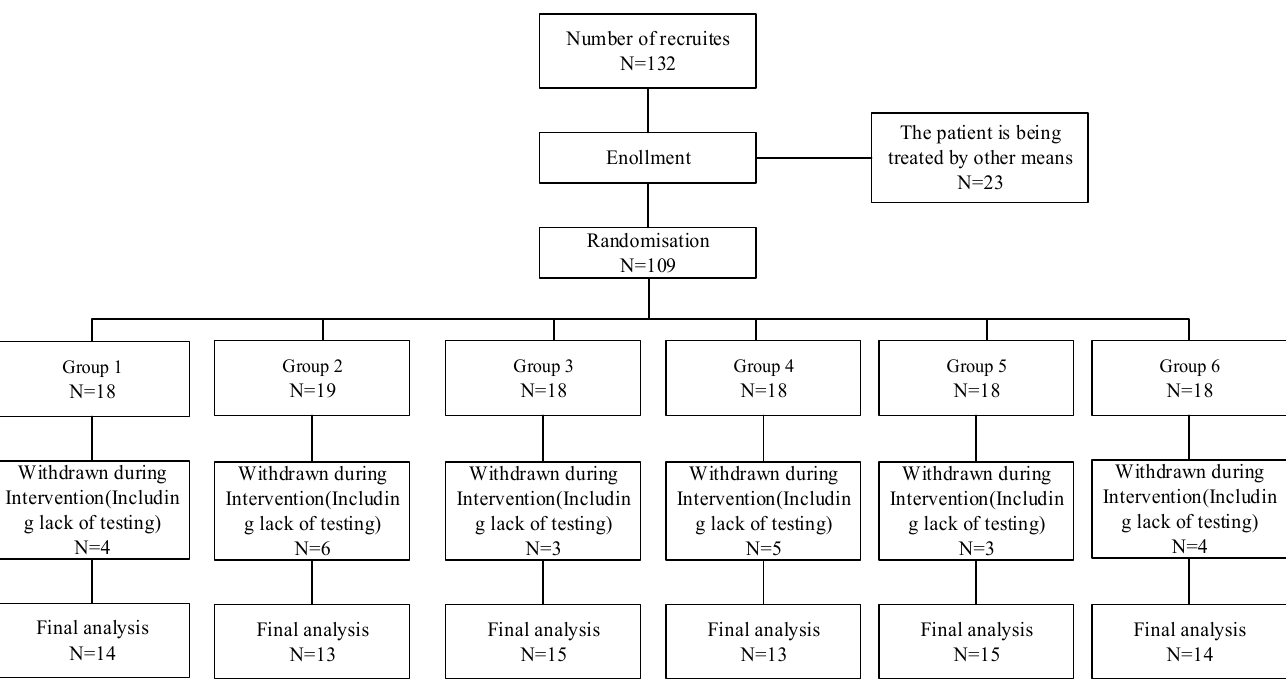
Figure 1. Grouping and final test of college students participating in the experiment.